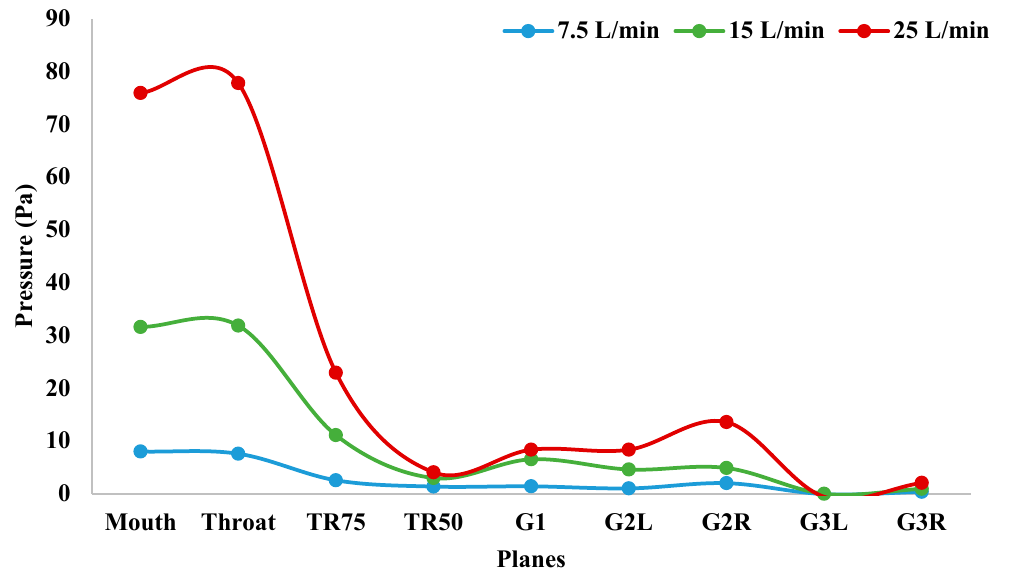
Figure 8. Pressure at selected positions of the whole lung airways with three different airflow rates. TR75, Trachea with stenosis 75%; TR50, Trachea with stenosis 50%; G1, Generation-1; G2L, Generation-2 at left lung; G2R, Generation-2 at right lung; G3L, Generation-3 at left lung; G3R, Generation-3 at right lung.